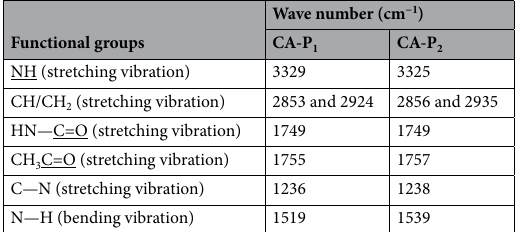
Table 1. FT-IR absorption bands in CA carbamate (CA-P 1 , CA-P 2 ).